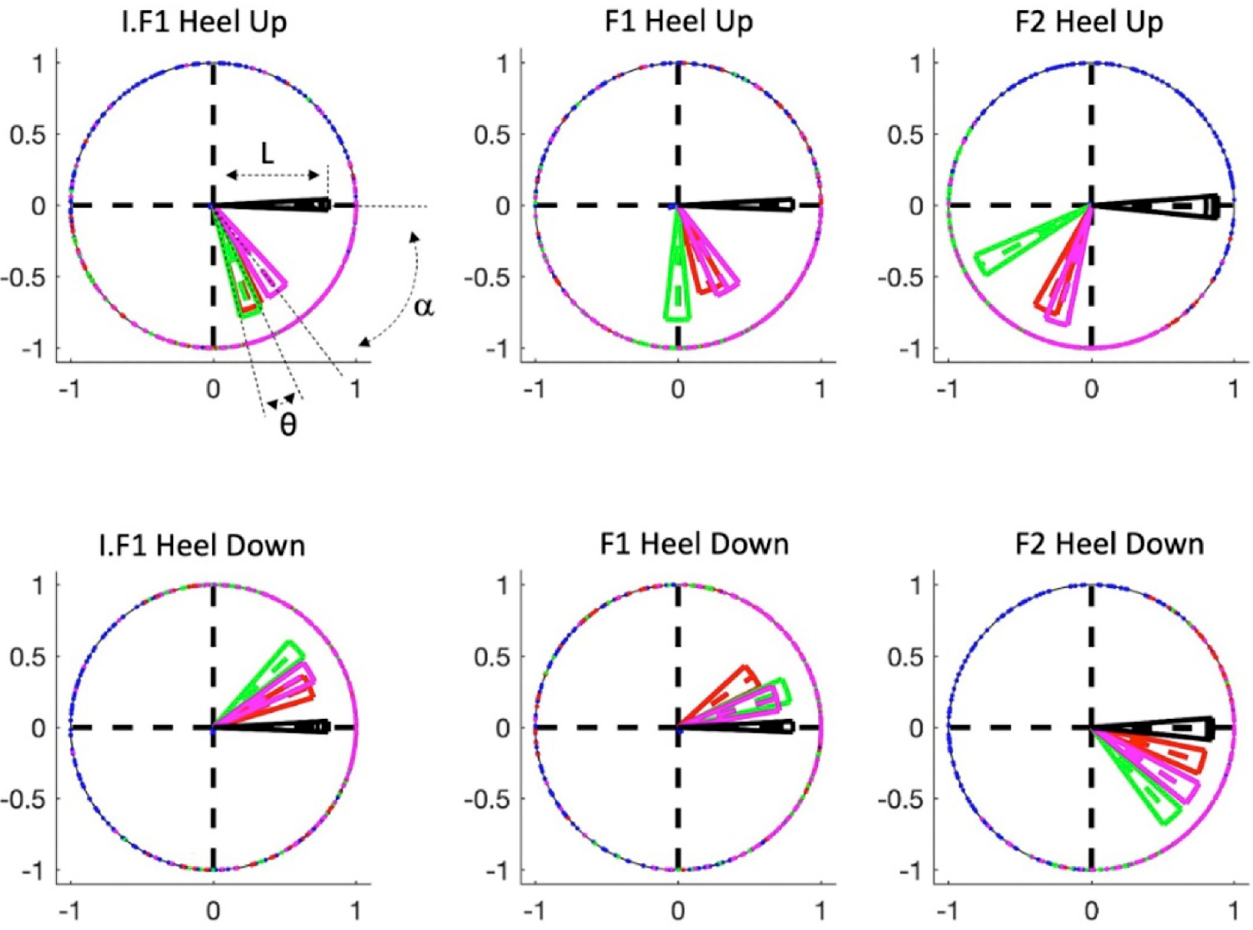
Fig 4. Circular statistics representation. Colored vectors represent, for each participant (P1 to P4 as blue, red, green, and magenta sectors, respectively), the angular direction ( α ) of a specific onset relative to the beat (black vector), as well as the magnitude of this direction (L). Vectors (for clarity, represented as the dotted line in the center of the wedge) are shown for each fragment (I.F1, F1, and F2), and the central angle θ of the vectors represents the 95% confidence interval of its angular direction. P1’s vector is so small that it is not visible in this figure. Confidence intervals are also given for the beat onsets. https://doi.org/10.1371/journal.pone.0284387.g004 PLOS ONE | https://doi.org/10.1371/journal.pone.0284387 April 18,